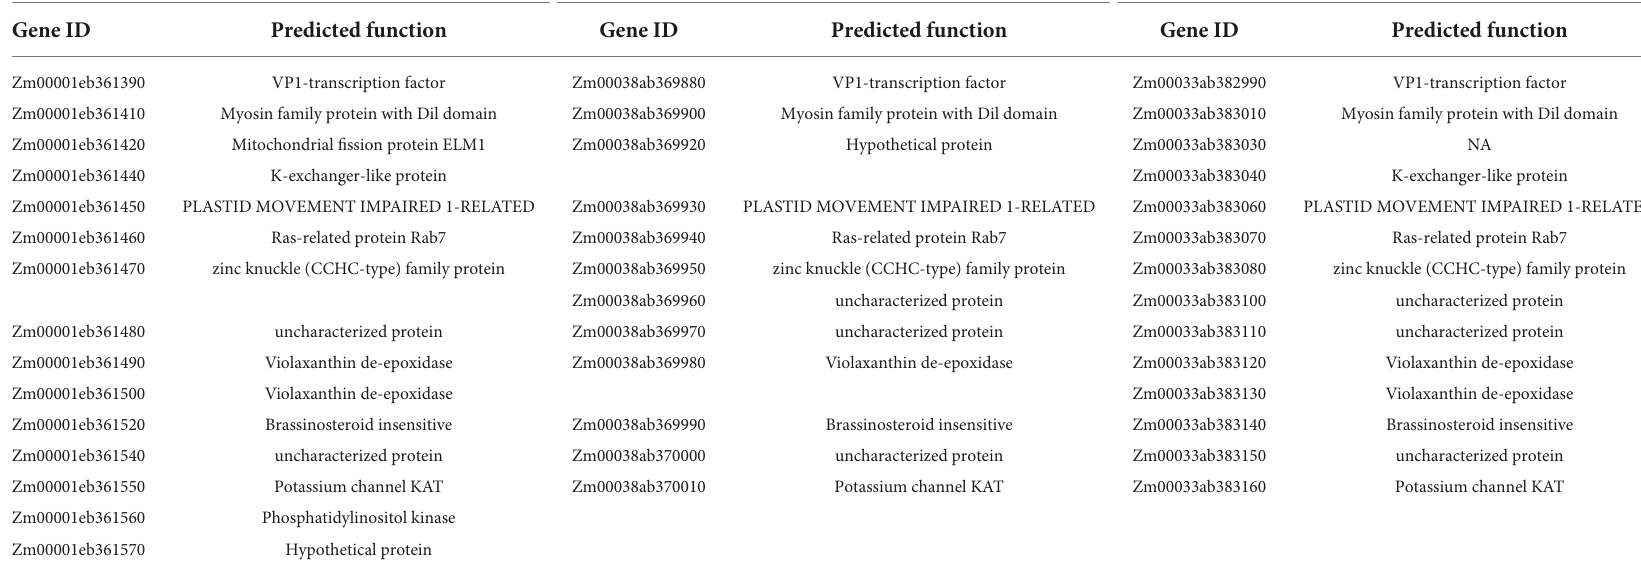
TABLE 4 Predicted candidate genes within the Ht3 -like region. B73 Oh7B M162W Gene ID Gene